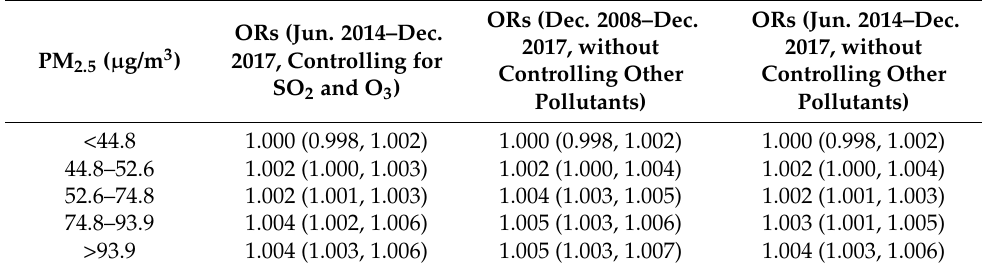
Table 2. Influence of PM 2.5 on gynecological cancers in Phase 4 with/without controlling other air